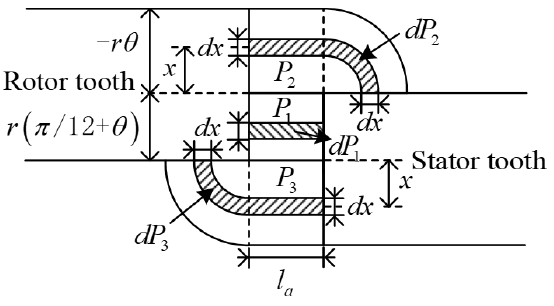
Figure 7. Schematic diagram of air gap magnetic circuit division.